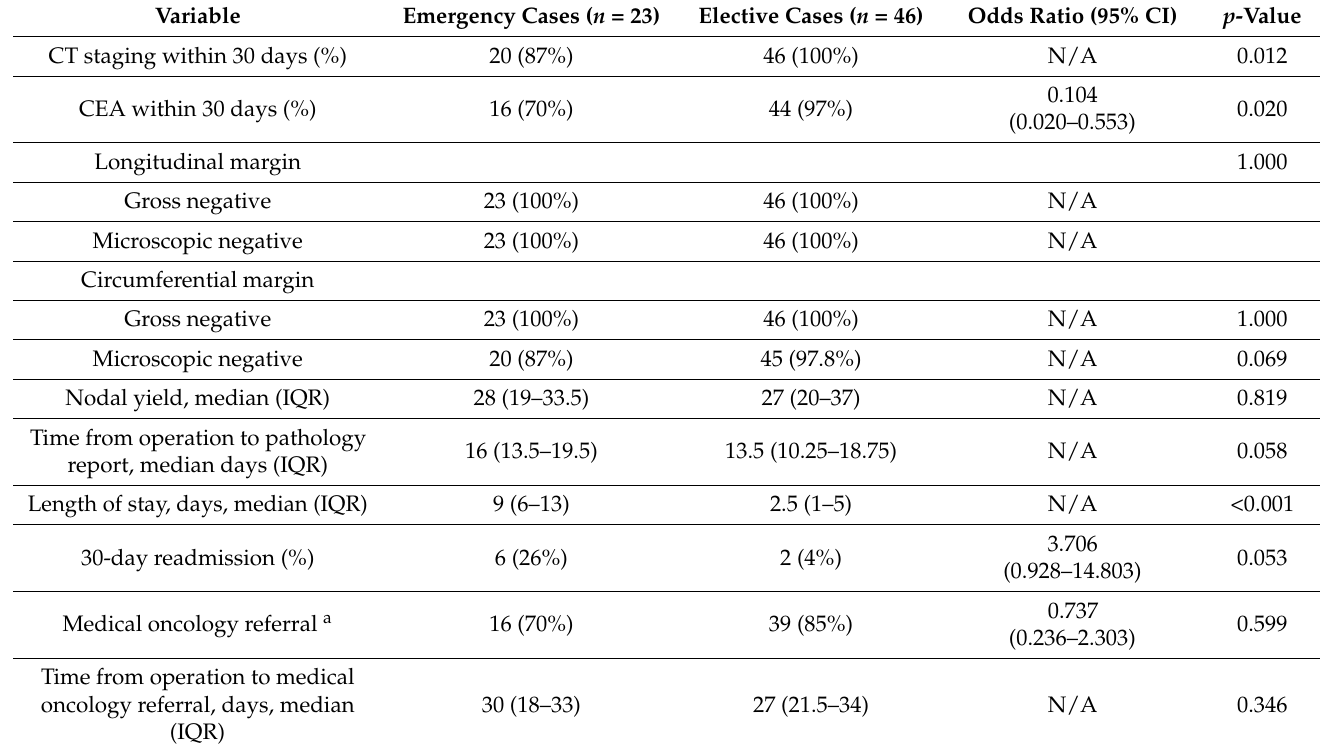
Table 2. Comparison of outcomes between patients undergoing emergency versus elective colon cancer